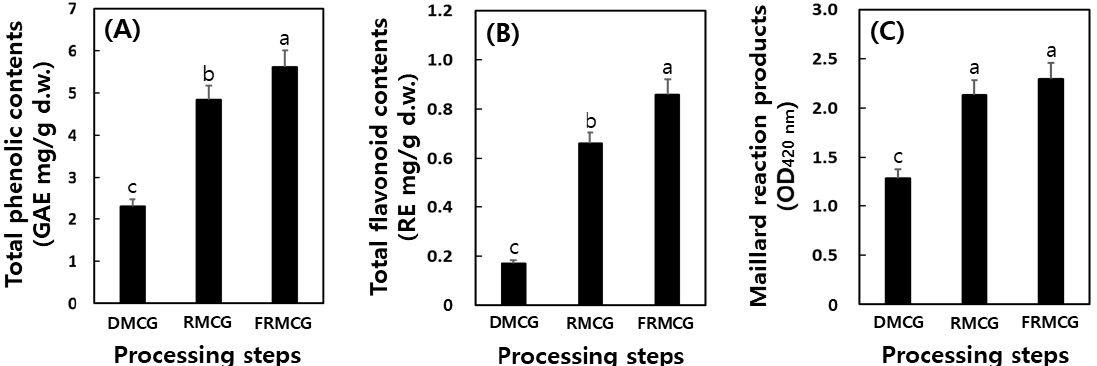
Figure 3. Change of the total phenolic ( A ) and total flavonoid ( B ) contents and maillard reaction products ( C ) during food processing steps of mountain-cultivated ginseng by the cocktail lactic acid bacteria. DMCG, dry mountain-cultivated ginseng; RMCG, red mountain-cultivated ginseng; and FRMCG, fermented red mountain-cultivated ginseng. All values are present as the mean ± SD of pentaplicate determination. Different letters correspond to the significant differences relating to the processing steps using Tukey ’ s multiple test ( p < 0.05).